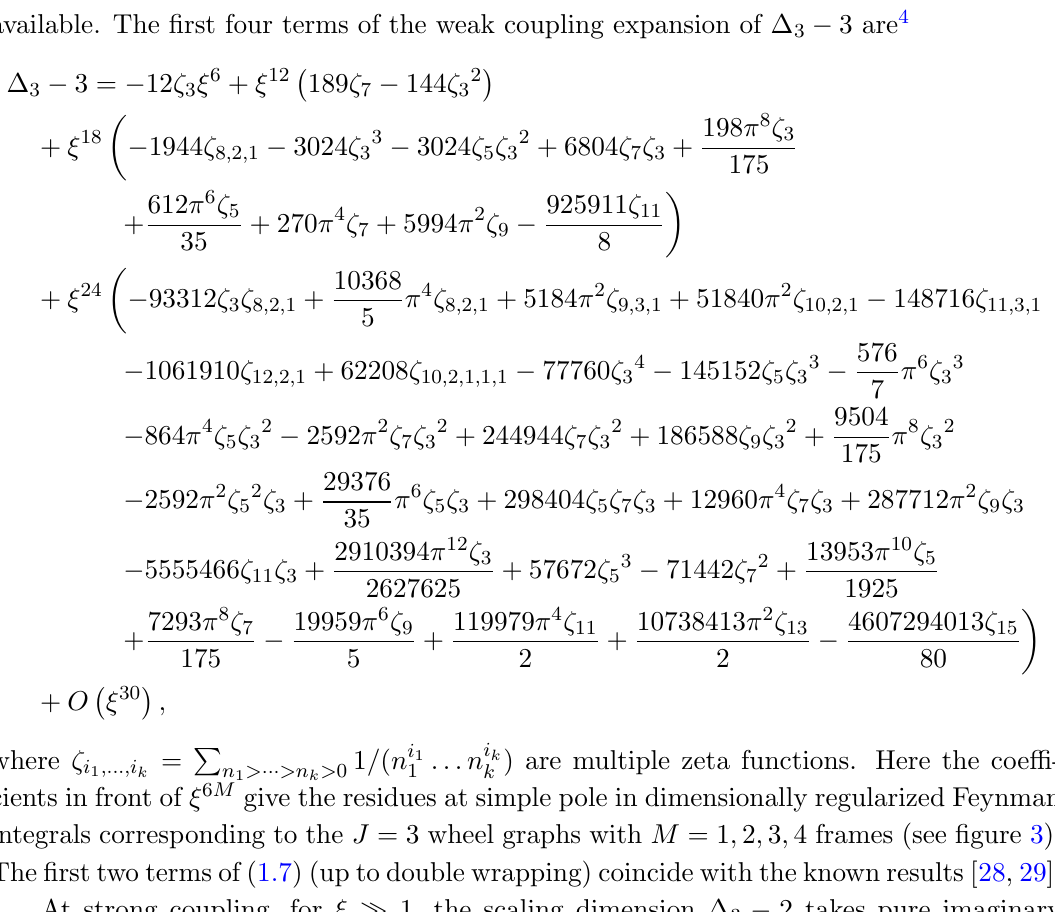
Figure 2 . Numerical results for the scaling dimension of the operator tr( (cid:30) 3 coupling (cid:24) 3 . We observe a \phase transition" at (cid:24) 3 ’ 0 : 21 where the scaling dimension takes the value (cid:1) = 2 and becomes imaginary. This point de(cid:12)nes the radius of convergency of the weak coupling expansion. The second branch, starting from (cid:1)(0) = 1, arises due to the symmetry of the Baxter equation (1.4) under (cid:1) ! 4 (cid:0)